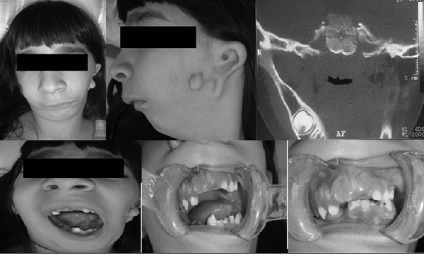
Figura 1. Microssomia